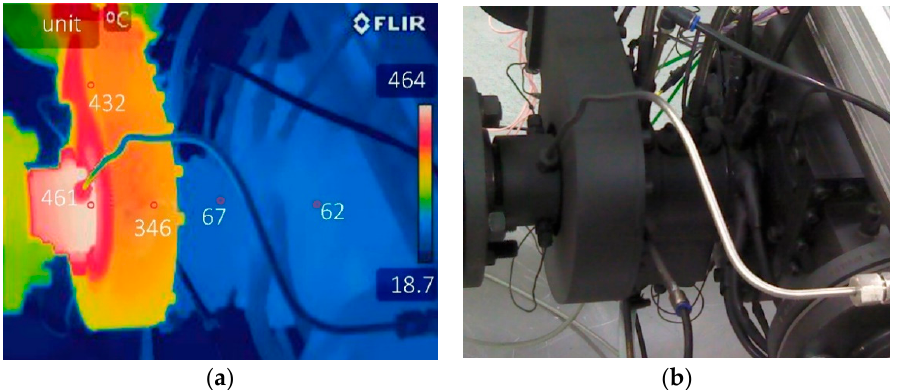
Figure 4. ( a ) Thermal image of MGT during test used to calculate the convective heat transfer coefficients of the wall sections. ( b ) MGT after coating. Table 5. MGT external wall free convection heat transfer coefficient calculations.